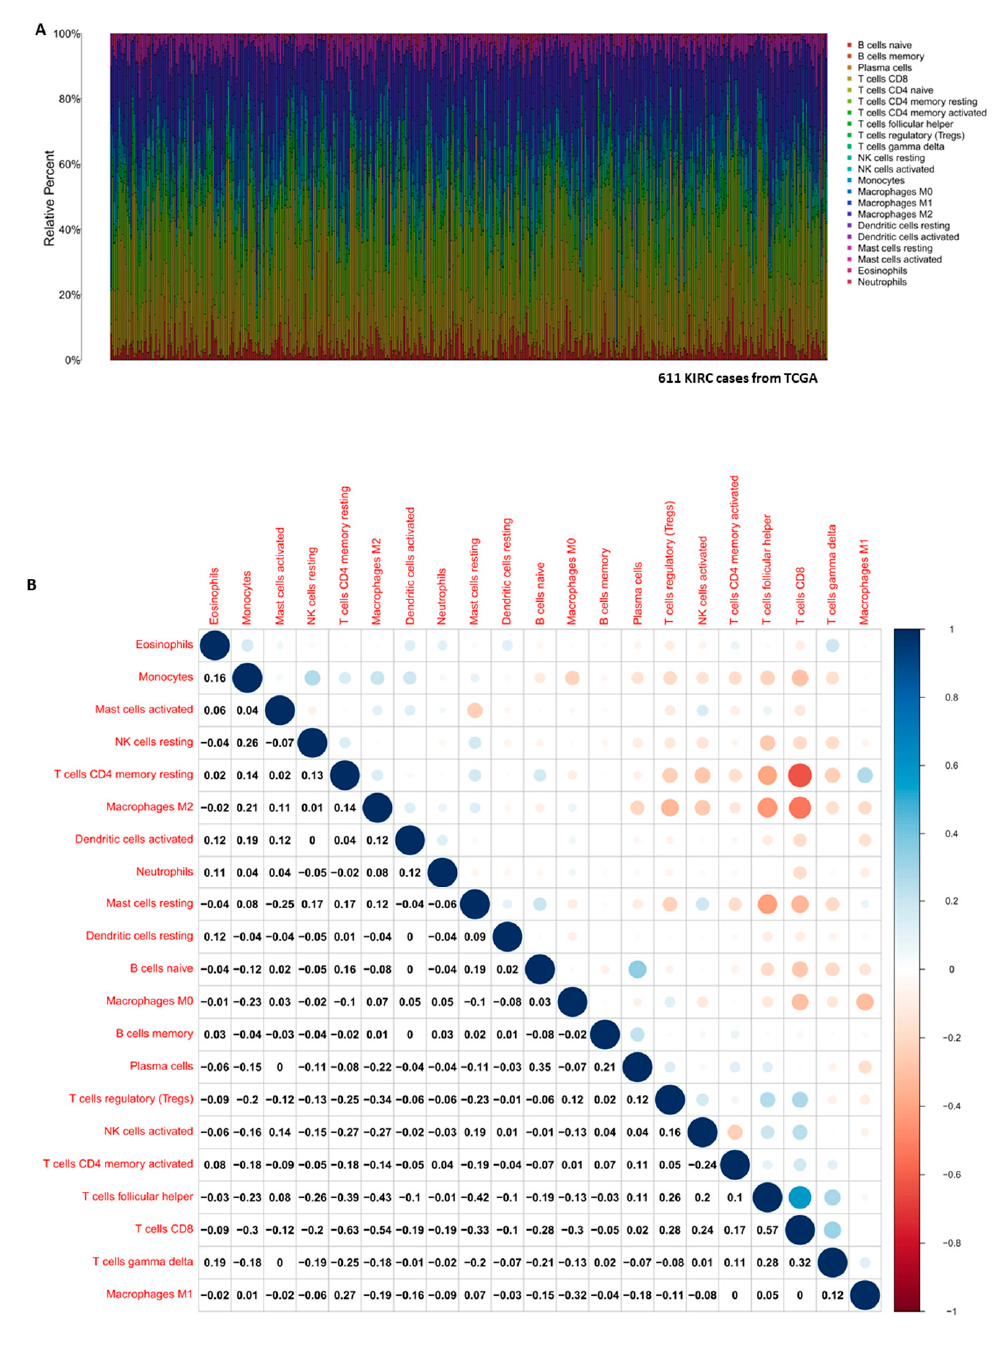
Figure 5. The TIC profile in the KIRC tumor samples and correlation analysis. ( A ) The barplot shows the proportion of 22 types of TICs in the KIRC tumor samples, columns are the 611 KIRC case samples and the different colors are types of TICs. ( B ) The heatmap shows the correlation between 22 TIC populations and the numbers in each tiny box indicate the p value of the correlation between two cell populations, the shade of each tiny color box represents the corresponding correlation value between two cell types, and the Pearson coefficient was used for the significance